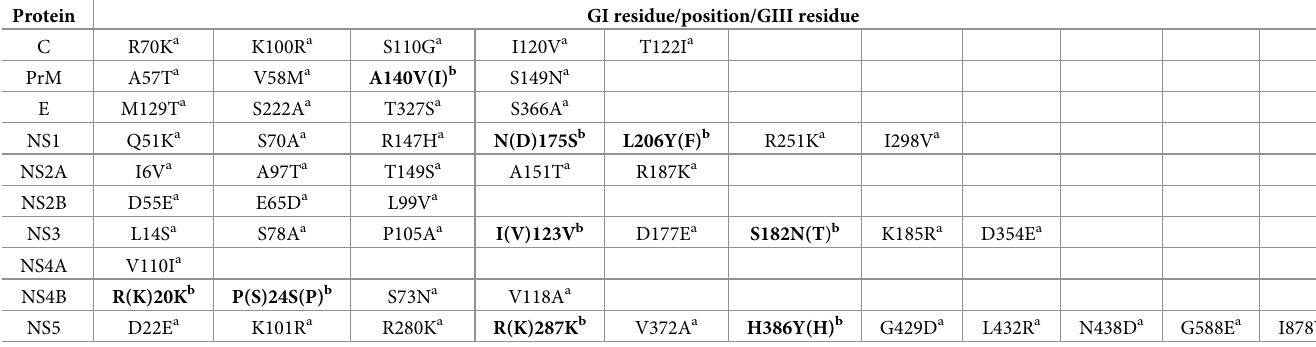
Table 1. Amino acid variations conserved between GI and GIII strains. Protein GI residue/position/GIII